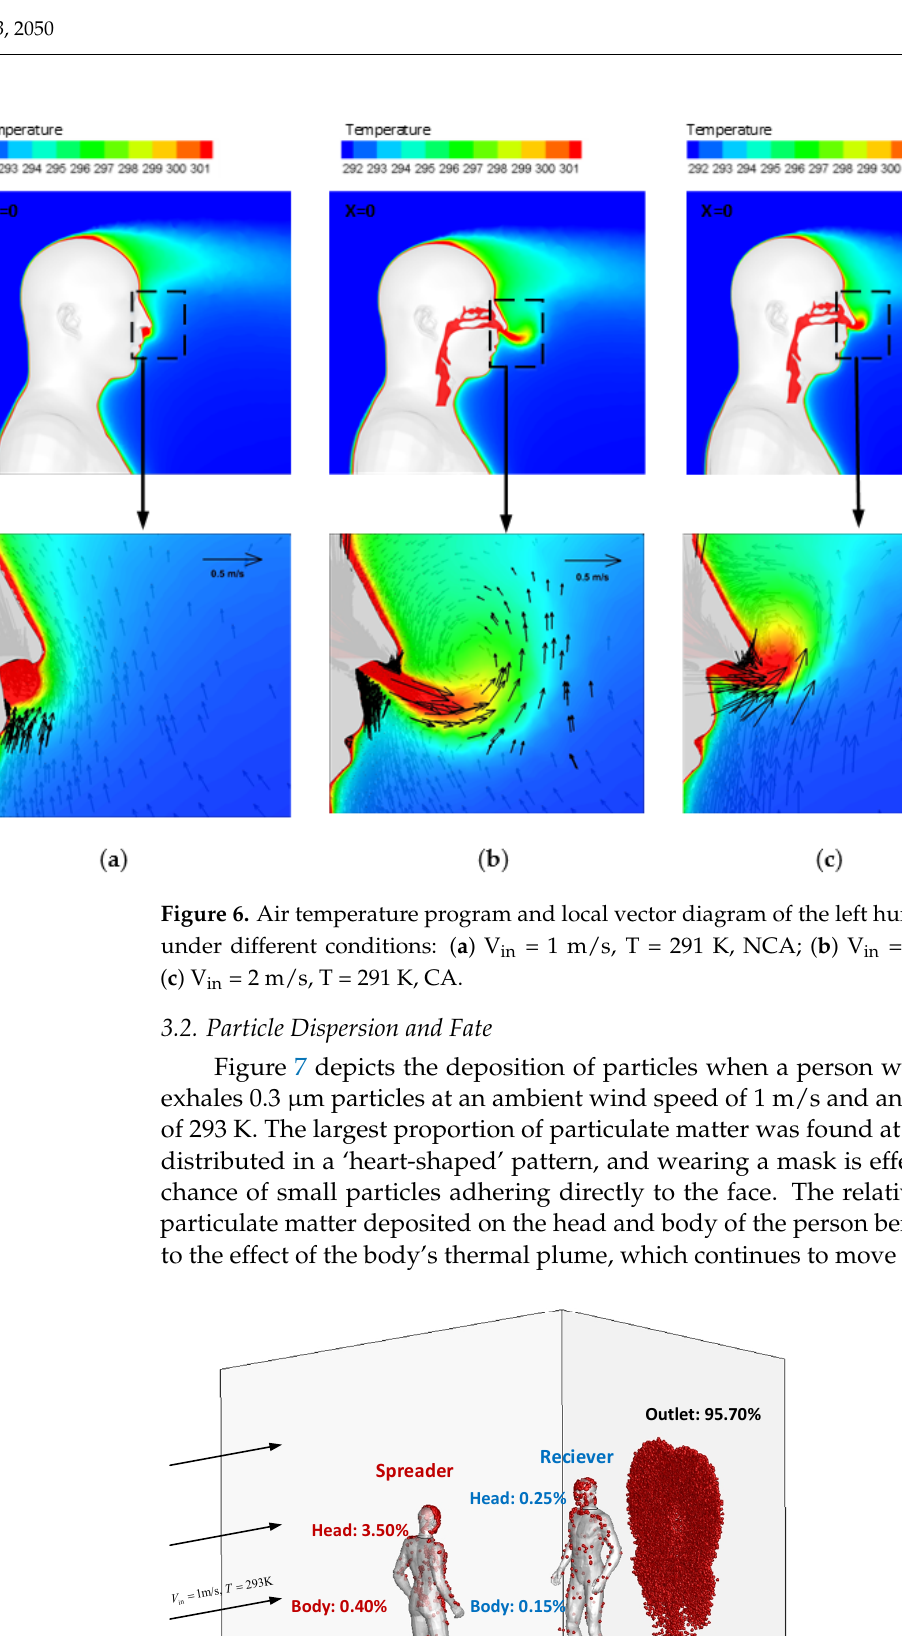
( d ) Figure 8. Wind velocity, temperature, and respiratory tract effect on particulate deposition in healthy humans: ( a ) DE at different wind speeds; ( b ) DE at different temperatures; ( c ) DE in the absence of respiratory tract; ( d ) Exposure to risk.